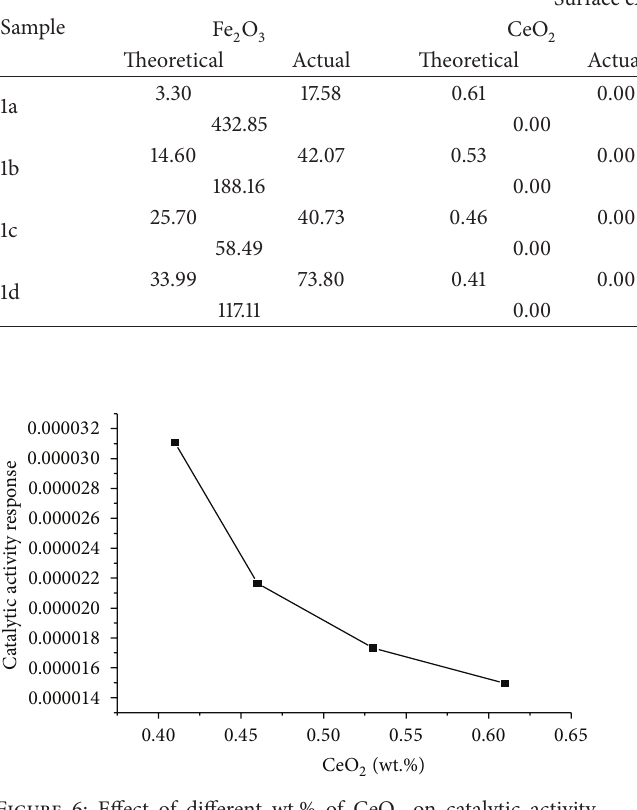
Figure 6: Effect of different wt.% of CeO 2 on catalytic activity response in series 1.